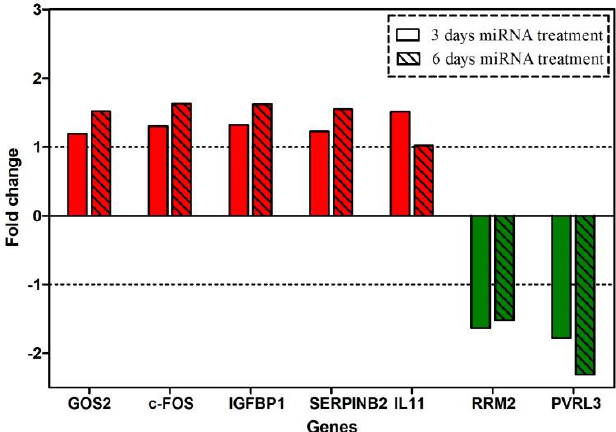
Figure 3. Microarray expression profiling data. Fold change of selected genes’ expression in response to targeting OPN for 3 or 6 days by miRNA treatment. Red bars show the fold changes of genes which were persistently up-regulated ( GOS2 , c-FOS , IGFBP1 , SERPINB2 ) or of a gene whose expression decreased back to the control level ( IL11 ); Green bars indicate the fold changes of genes which were persistently down-regulated ( RRM2 , PVRL3 ). Dashed lines indicate the no-effect level regarding gene expression modulation.